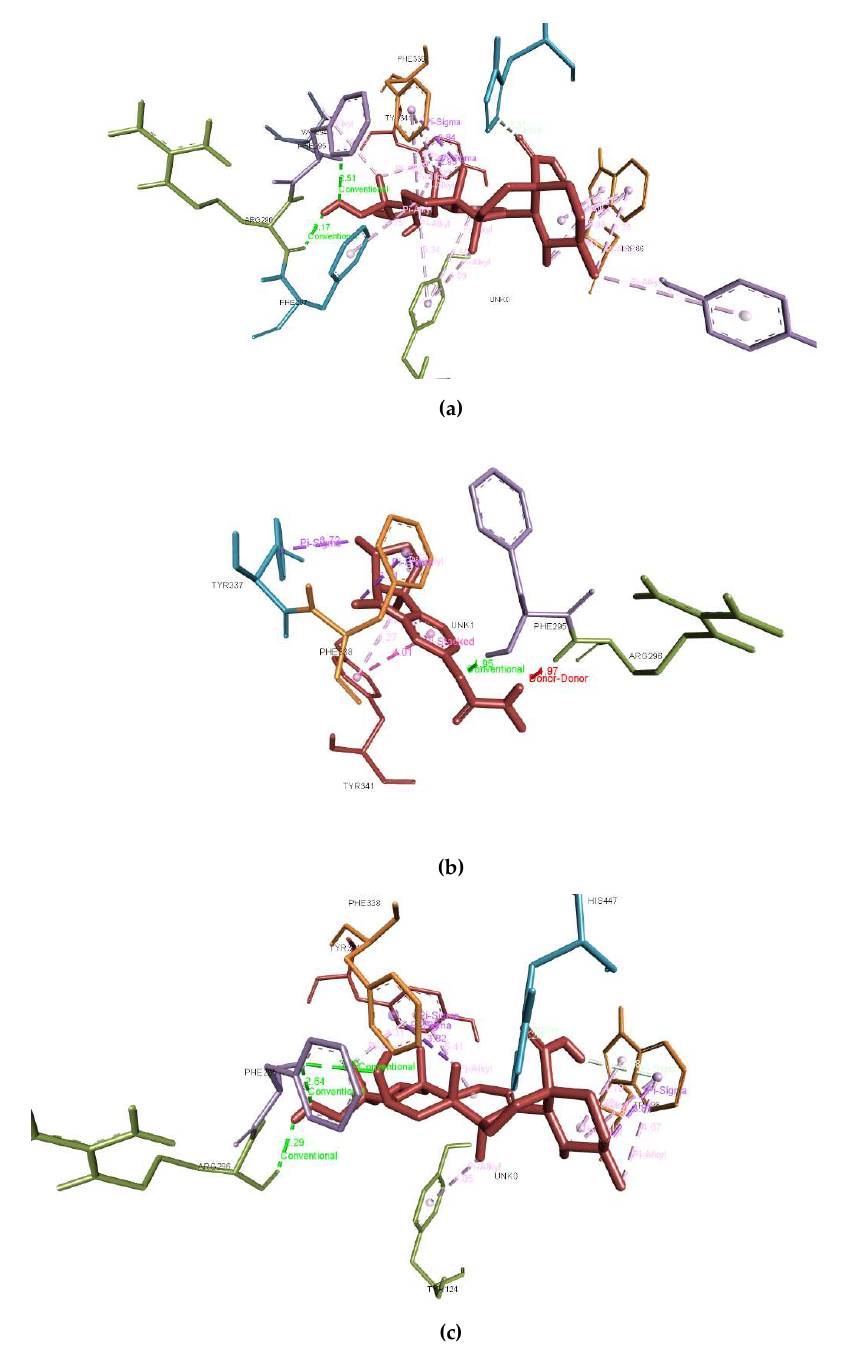
Figure A1. The bond length of respected interactions between compounds and amino acids ( a ) eserine, ( b ) asiatic acid, and ( c ) madecassic acid with the active sites of AChE.